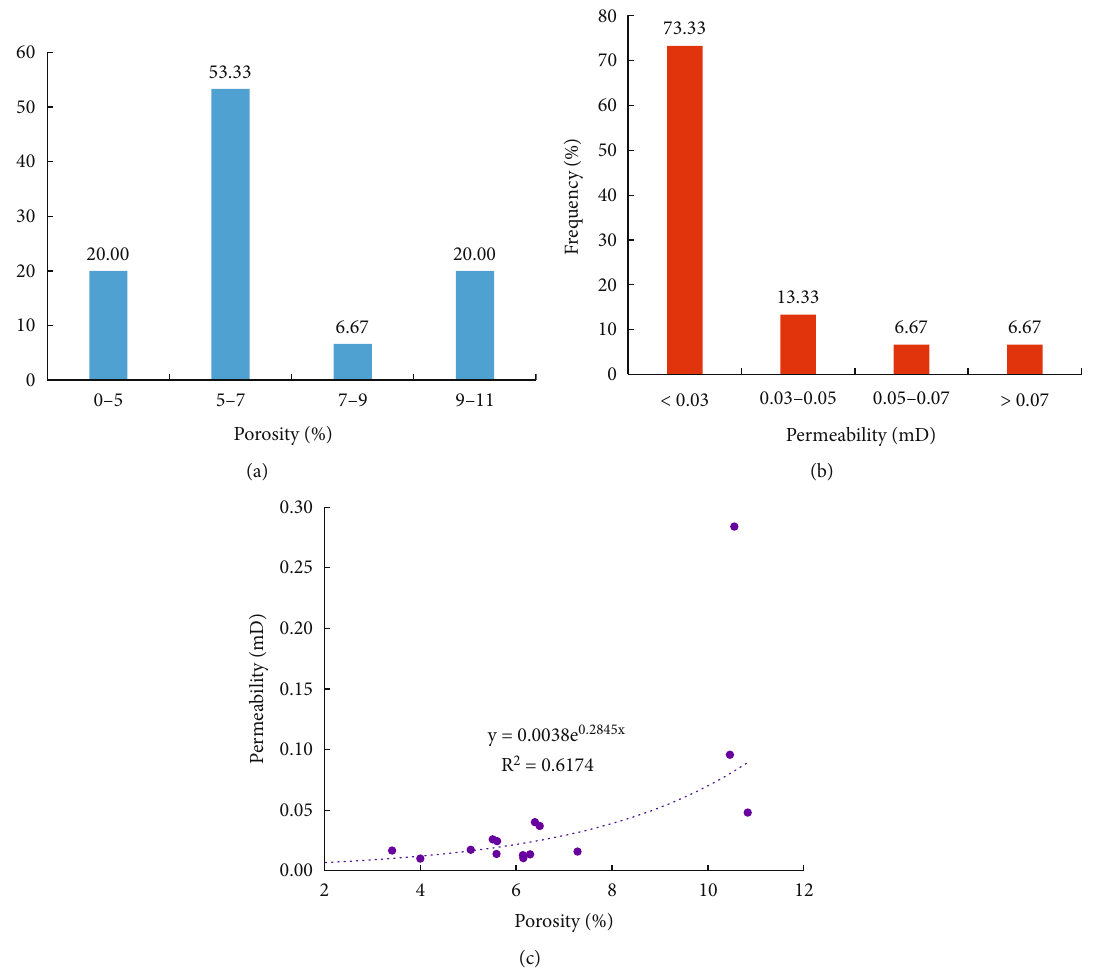
Figure 3: Petrophysical characteristics of Chang 6 porosity-permeability